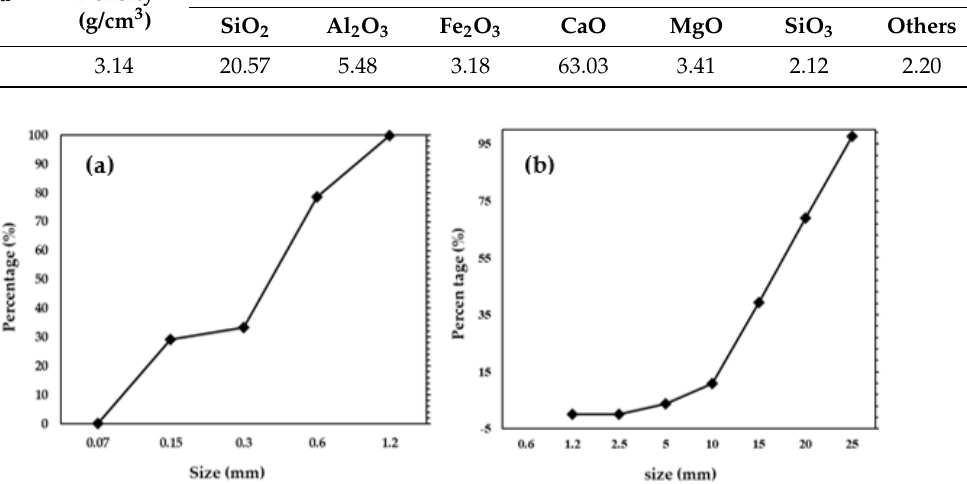
Table 2. Chemical composition and properties of OPC used in present study. Figure 2. Particle size distribution of ( a ) fine and ( b ) coarse aggregates. Table 3. Mix proportion of concrete used in this